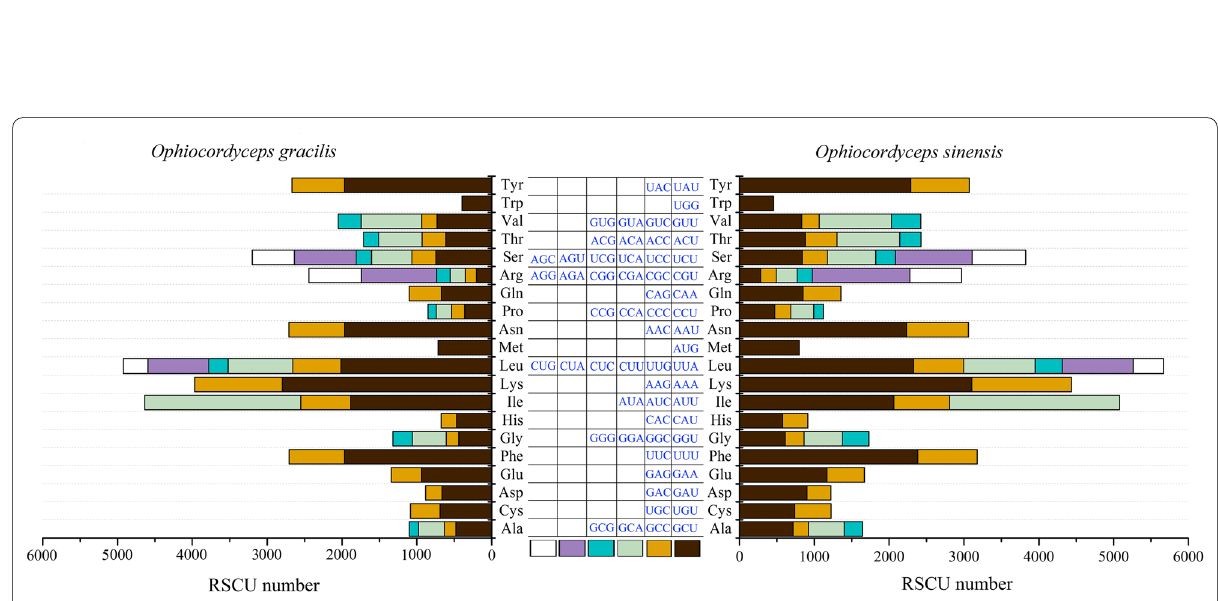
Fig. 5 Relative synonymous codon usage (RSCU) in PCGs of Ophiocordyceps gracilis and O. sinensis (Kang et al.